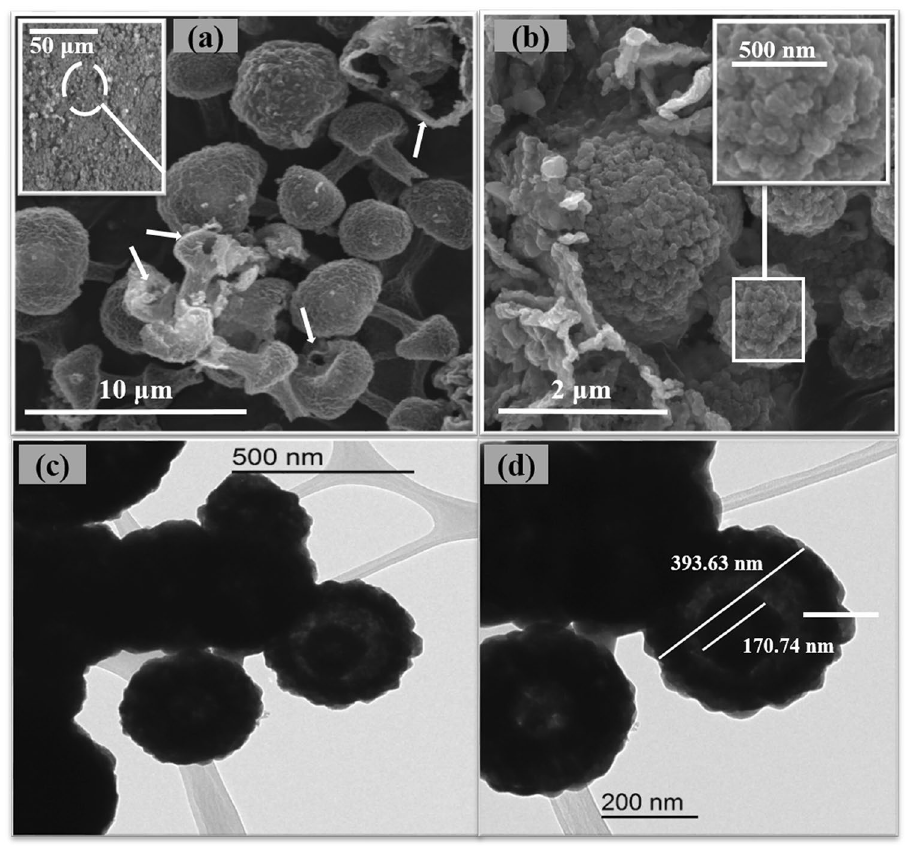
Figure 2. ( a ) And ( b ) typical SEM micrographs of CuO/ZnO-DSDSHNM, ( C ), and ( d ) TEM images of CuO/ ZnO-DSDSHNM.